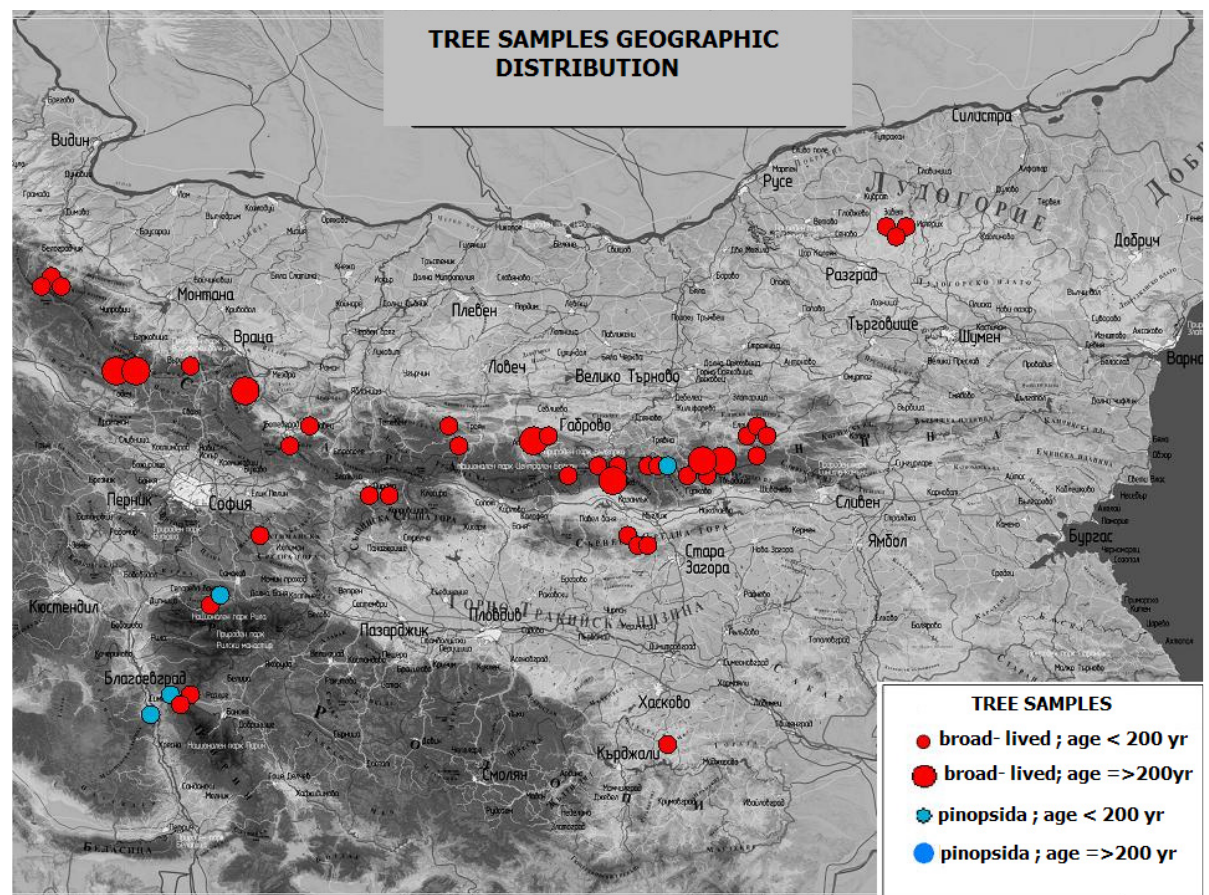
Figure 1. The tree samples locations on the territory of Bulgaria (the whole collection). The youngest sample (“Trojan-01”, beech) is 57 years old, while the oldest (“Rositsa-01”, beech too) is 24 ± 5 years old. The oldest pinopsida sample is spruce (“Govedartsi-01”, age 134 years), while the age of oldest oak sample is 175 years. The sample distribution by age is shown on Figure 2. The mean age of the whole samples collection is 128 years.